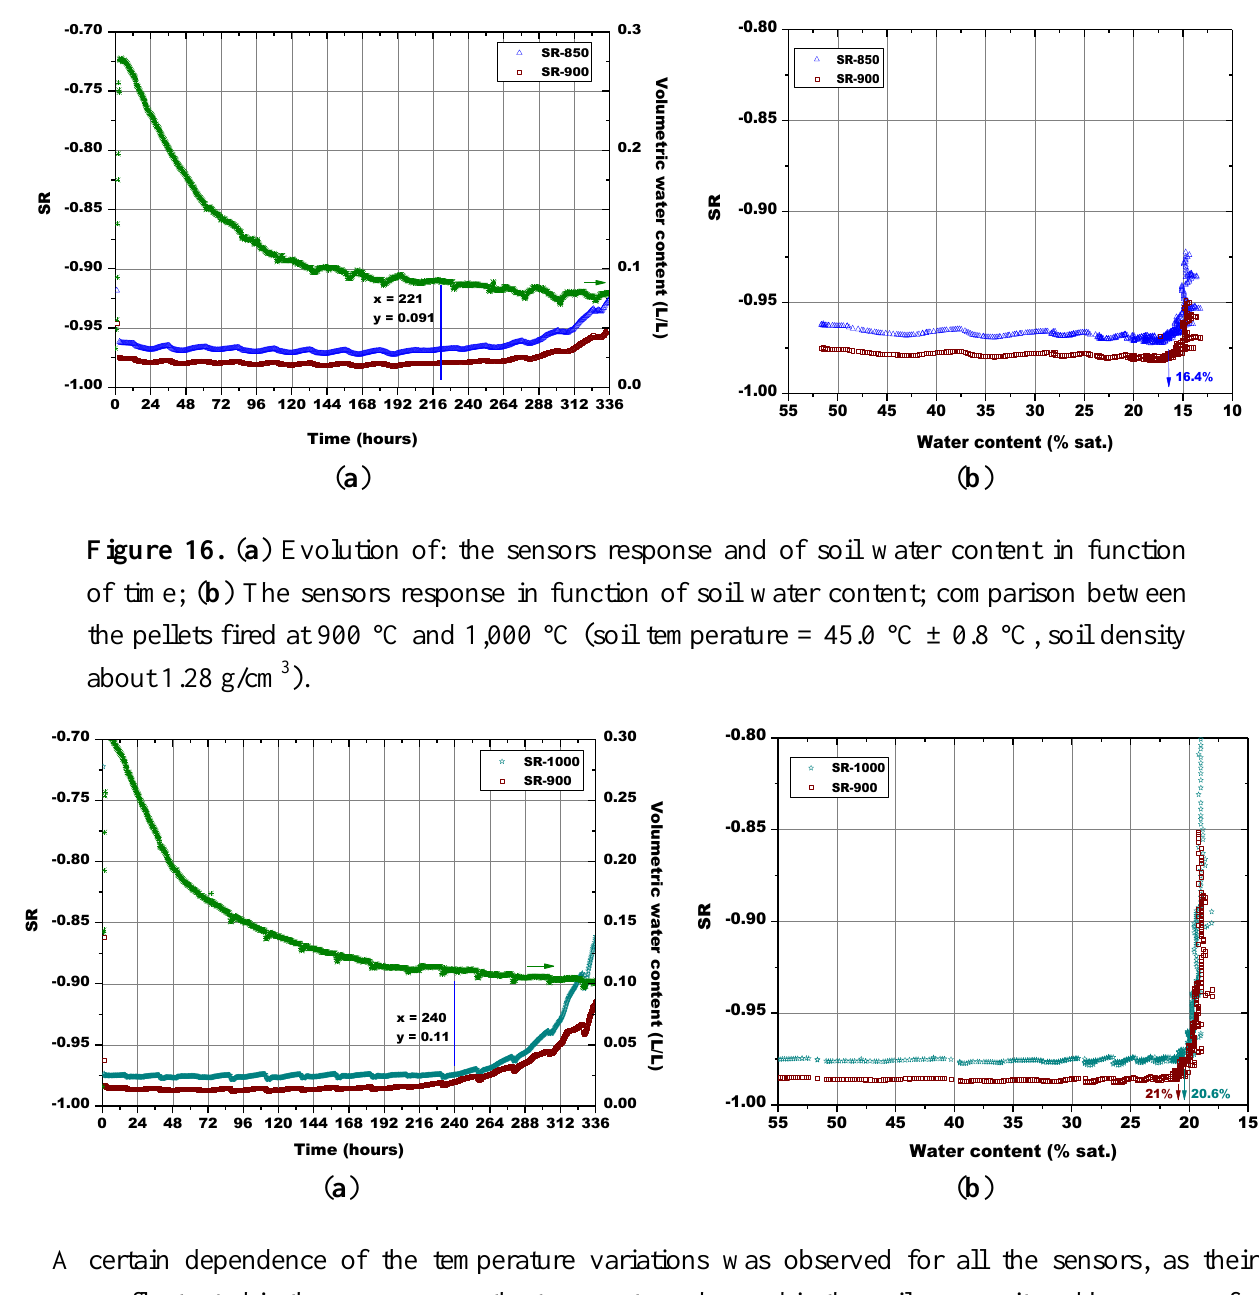
Figure 15. ( a ) Evolution of: the sensors response and of soil water content in function of time; ( b ) The sensors response in function of soil water content; comparison between the pellets fired at 850 °C and 900 °C (soil temperature = 38.7 °C ± 1.4 °C, soil density about 1.28 g/cm 3 ).